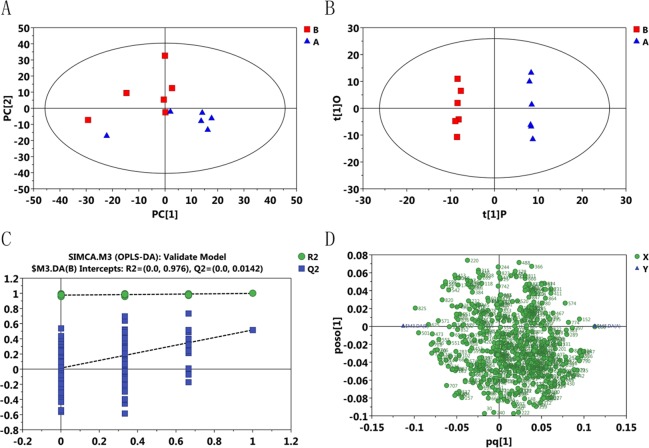
The multivariate data analysis among the B and A group (5°C vs 16°C).A, the scatter plot of the PCA model. B, The OPLS-DA model. C, 200-permutation test was further applied to validate the OPLS-DA model. D, loading plot based on the OPLS-DA model.